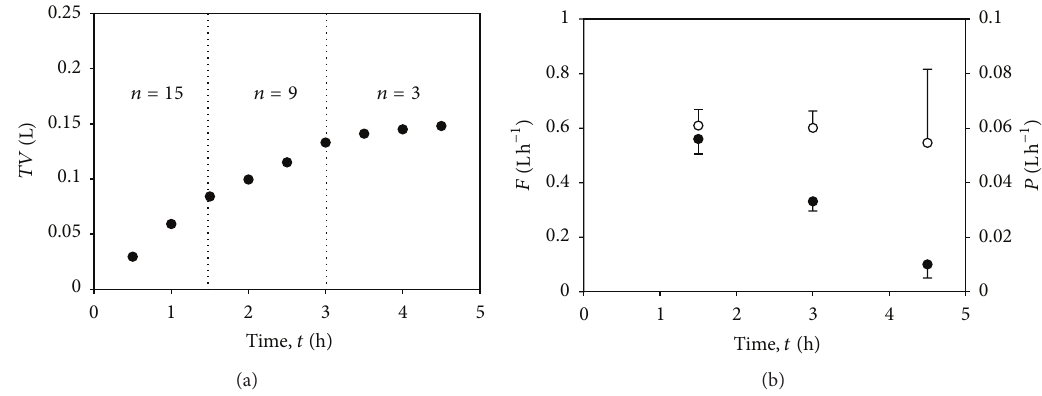
Figure 4: Test of fluorometer controlled apparatus (FCA). Measurement of filtration rate with a varying number of mussels placed in the experimental aquarium. (a) Total volume of algal suspension added ( 𝑇𝑉,∙ ) when an algal stock suspension ( 0.72 × 10 6 cells mL −1 ) is used for keeping the algal concentration in the aquarium constant (4,380 ± 590cells mL −1 ). Initially, 15 mussels (mean ± S.D., shell length = 21.1 ± 1.5 mm) were used; later after 1.5h the number of mussels was reduced to 9, and further after 3 h to 3 mussels. (b) Calculated filtration rate ( 𝐹